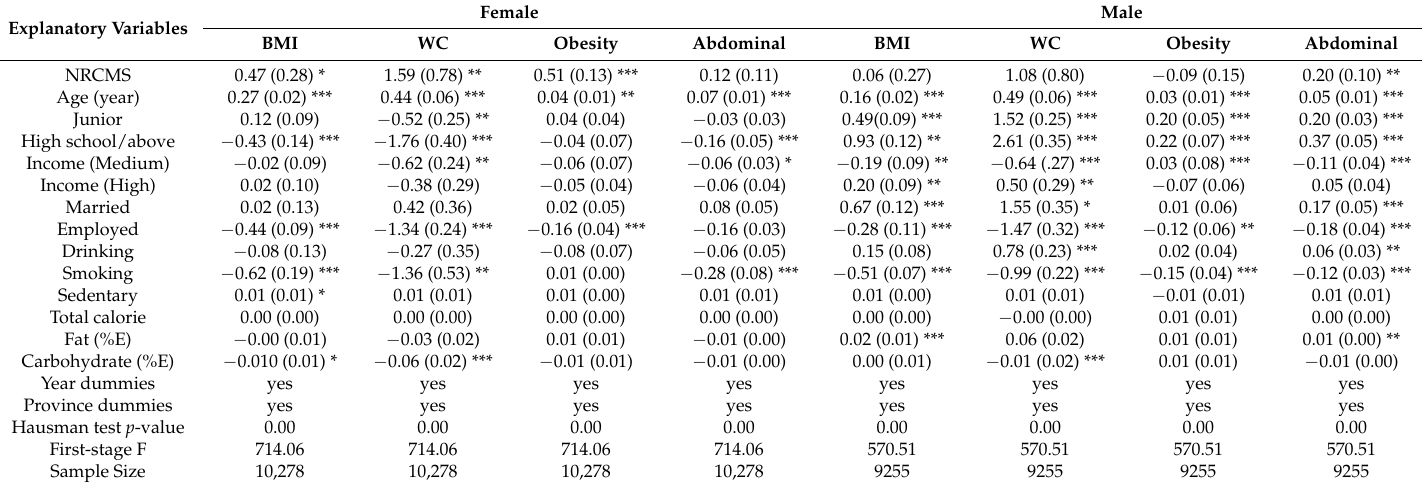
Table A5. Effects of the NRCMS on the probabilities of having general obesity and abdominal obesity. Female Male Explanatory Variables Obesity Abdominal Obesity